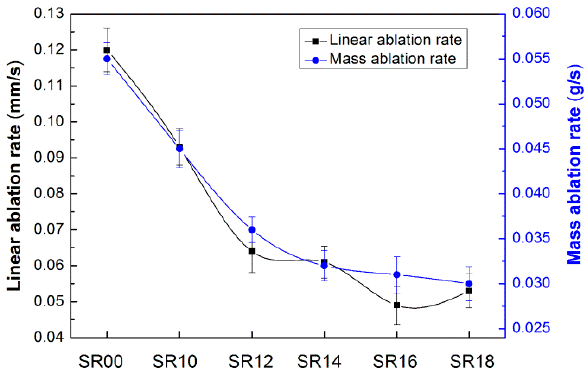
Figure 6. Characteristic ablation results of SR composites.